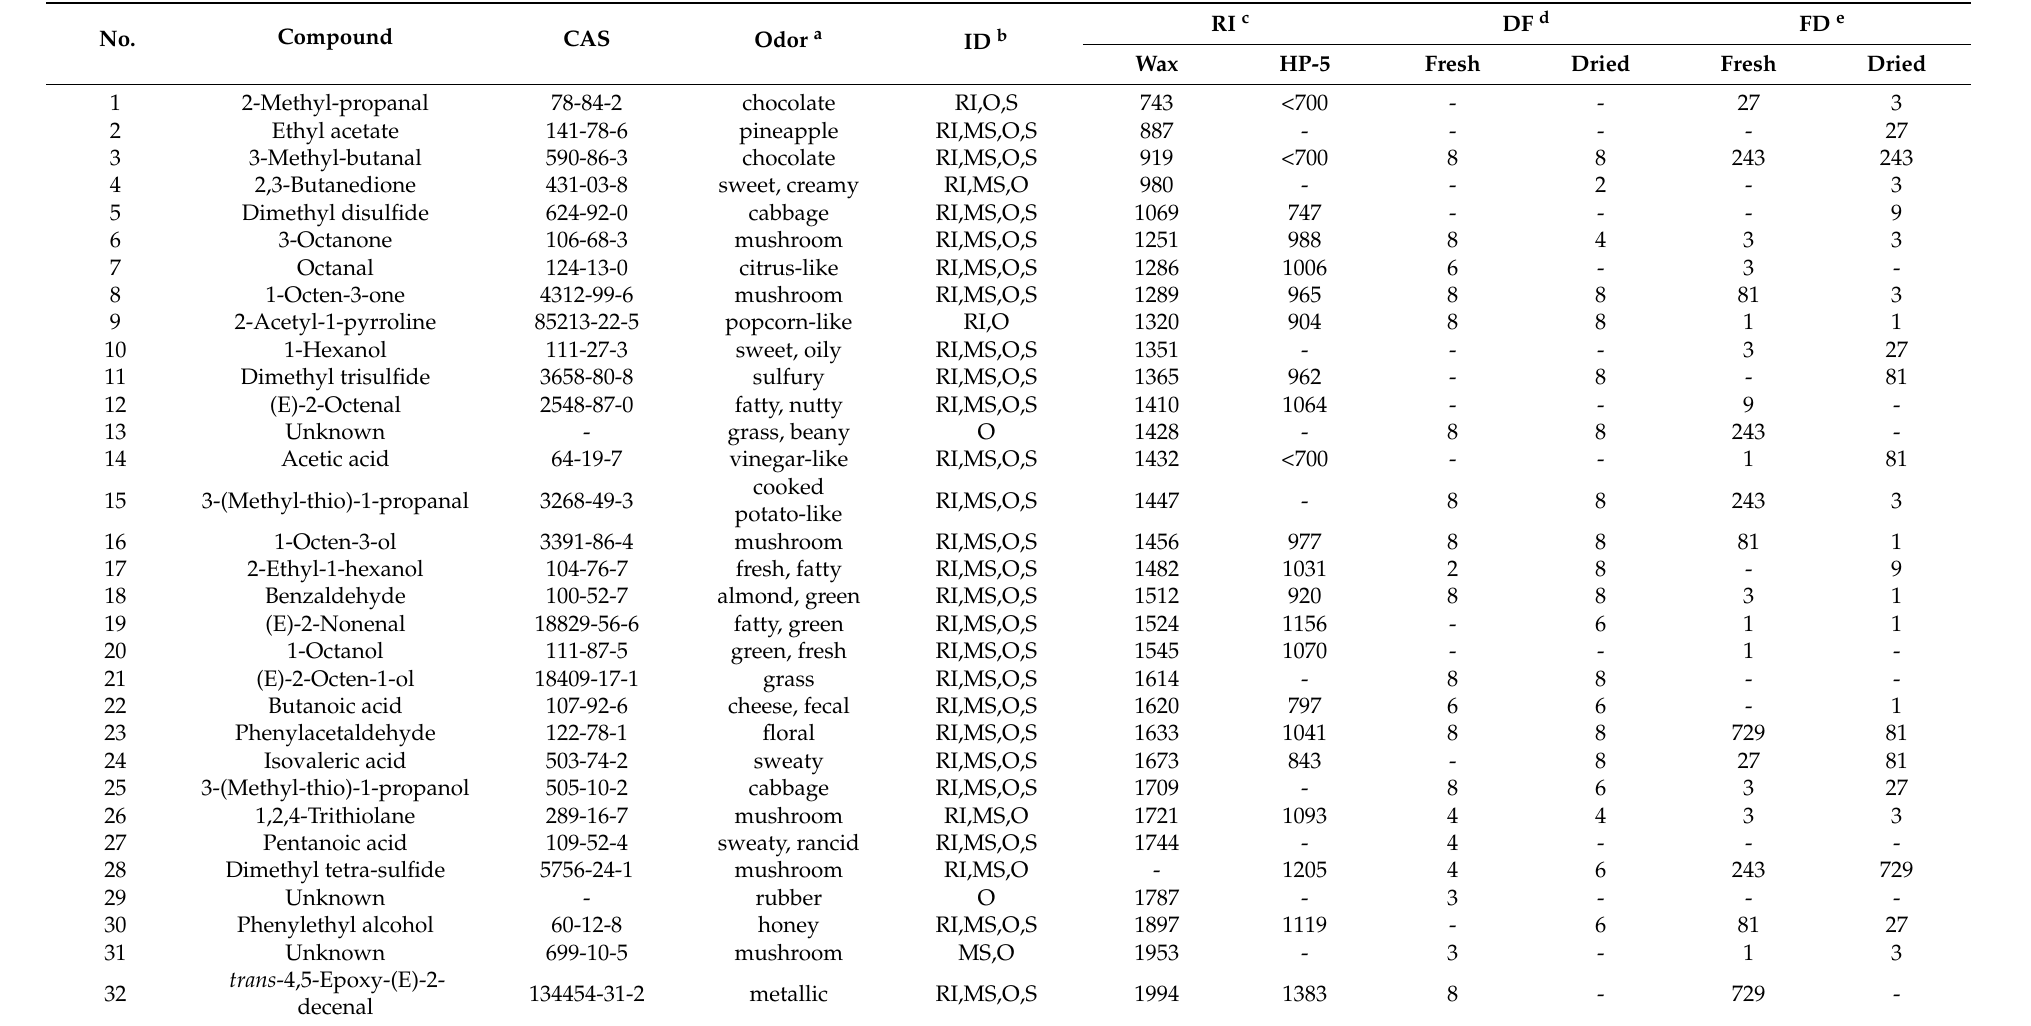
Table 2. Odorants determined in fresh and hot-air-dried shiitake mushrooms by HS-SPME and DSE-SAFE combined with DFA and